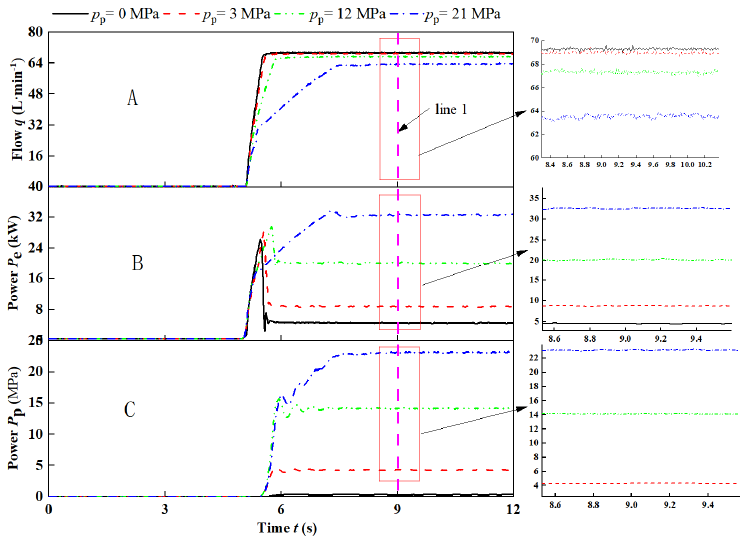
Figure 7. Working performance of a pure variable-speed electro-hydraulic power source.